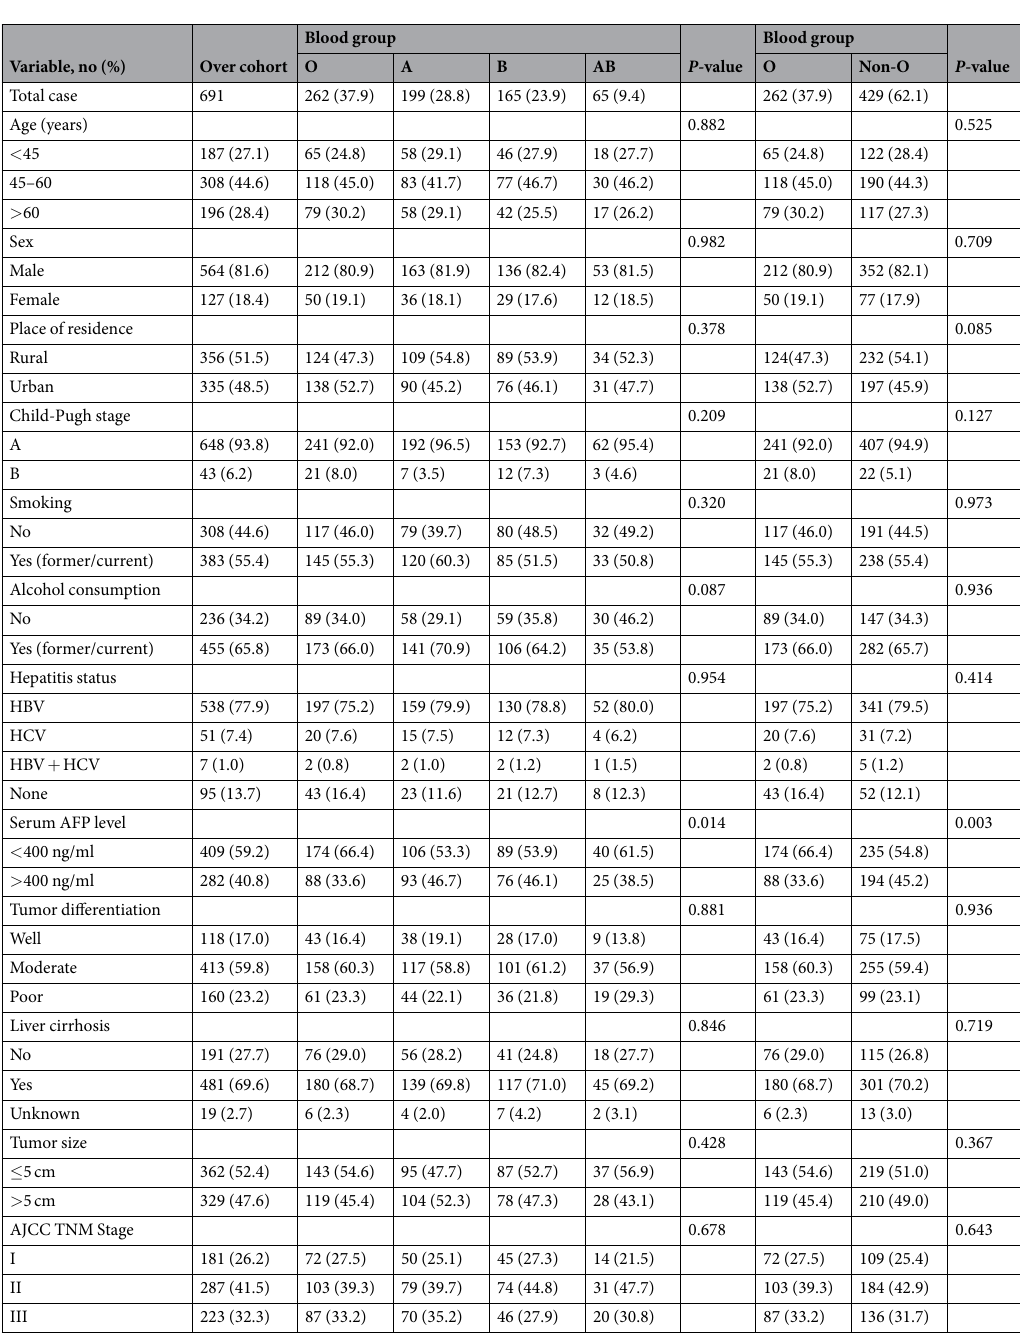
Table1. Patient clinicopathologic characteristics, stratified by ABO blood type. Notes: AFP α -fetoprotein; HBV hepatitis B virus; HCV hepatitis C virus; TNM Tumor node